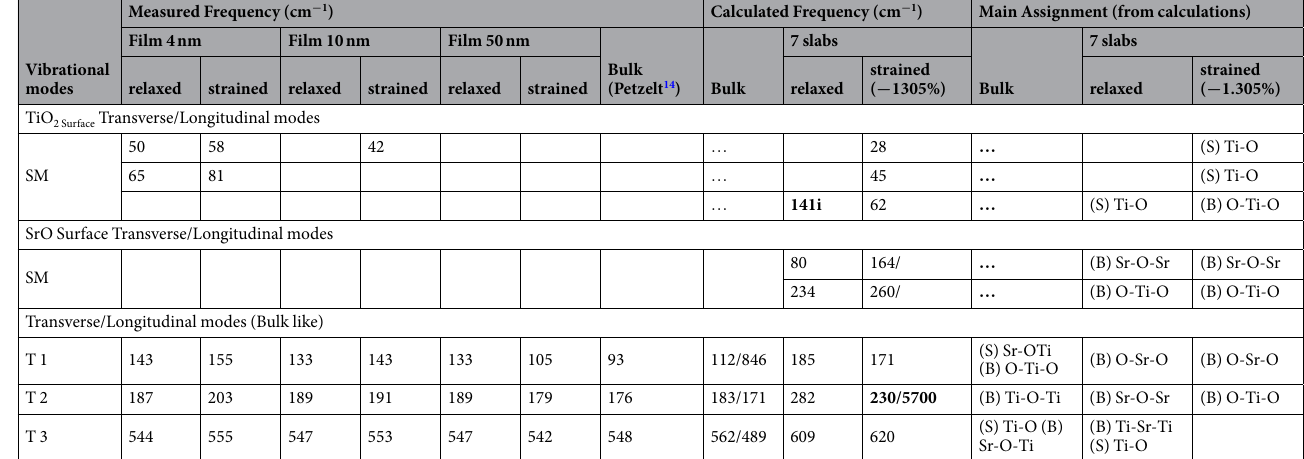
Table 1. Measured and Calculated Frequencies of the main modes for ultrathin films and Bulk together with some assignment. Left: Measured frequencies of the main optical modes for strained and relaxed STO thin films of various thicknesses (~50, 10 and 4 nm) together with experimental bulk frequencies from the literature 37 . Center: Calculated frequencies of the main optical modes for − 1.305% strained and relaxed STO slab of 7 layers together with calculated bulk frequencies. All modes are divided into Transverse Modes T1, T2 and T3 and Surface/Soft Modes (SM). SM are classified according to STO terminated surface: SrO or TiO 2 . The presence of imaginary mode at 141i (in bold) shows that the relaxed slab is metastable. The modes contributing to the large dielectric constant for strained slabs (surface modes and the large LO/TO splitting T2 mode) also appear in bold. Right: The assignment based on calculations of the main optical modes for strained and relaxed together with calculated bulk frequencies are presented in the three last